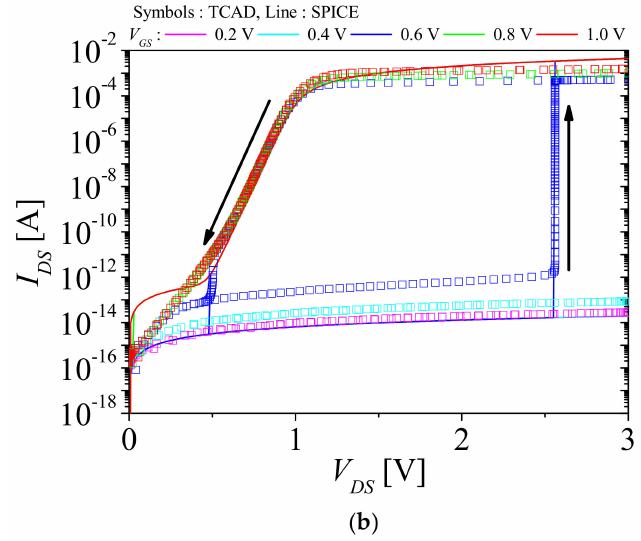
Figure 5. Simulation Program with Integrated Circuit Emphasis (SPICE) results of macro–model of